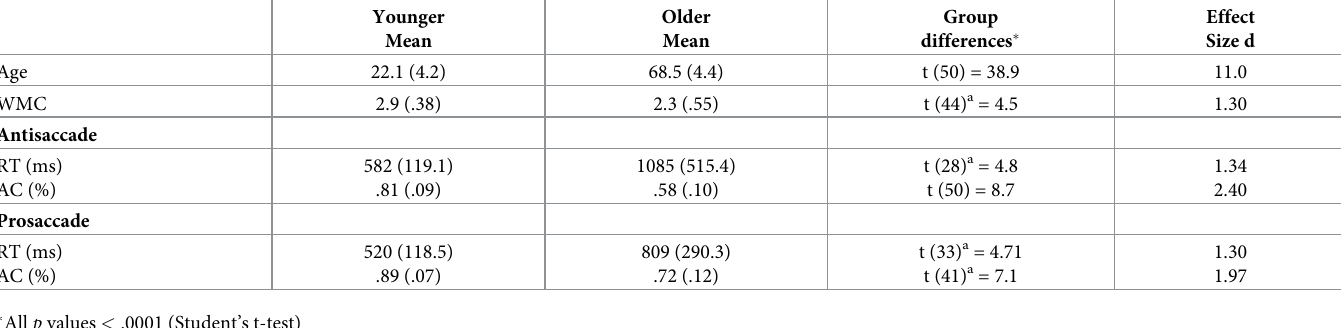
Table 6. Comparisons between younger and older adults in Experiment